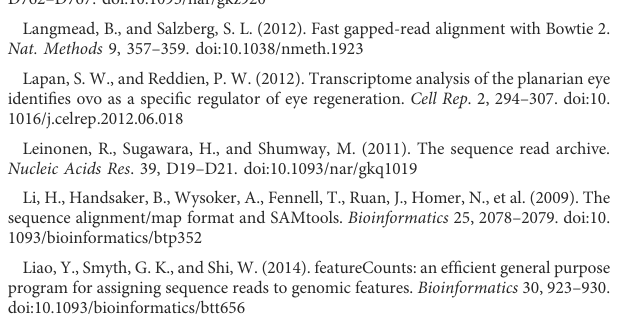
heatmap or volcano plot based on transcripts that are selected by the users. Transcript selection is performed using free text search of transcript IDs or their putative annotation, as previously described (Dagan et al., 2022). 2) Showing differentially expressed genes of an assay as a heatmap, a volcano plot, or a table in the datasets that are available and analyzed with PLANAtools. 3) Presenting gene expression across datasets by comparing the expression of a single gene in control and treatment samples across assays. 4) Finally, to intersect a list of queried genes with a list of differentially expressed genes in an assay. Resulting visualizations are interactive online, and downloadable as vector images for further processing. The processed gene expression tables and differential gene expression analyses are also available for